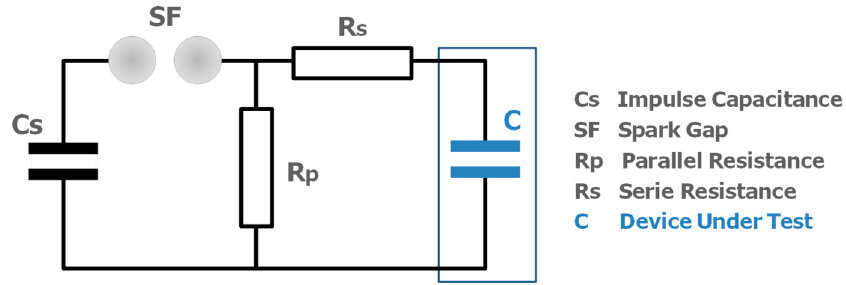
Figure 2. Marx generator diagram.